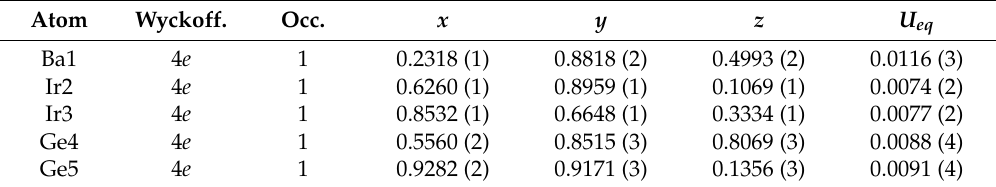
Table 2. Atomic coordinates and equivalent isotropic displacement parameters for BaIr 2 Ge 2 in space group P 2 1 / c . U eq is defined as one-third of the trace of the orthogonalized U ij tensor (Å 2 ). Atom